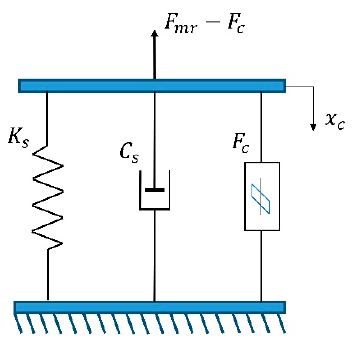
Figure 3. Schematic view of the Bouc-Wen model for the MR damping system.